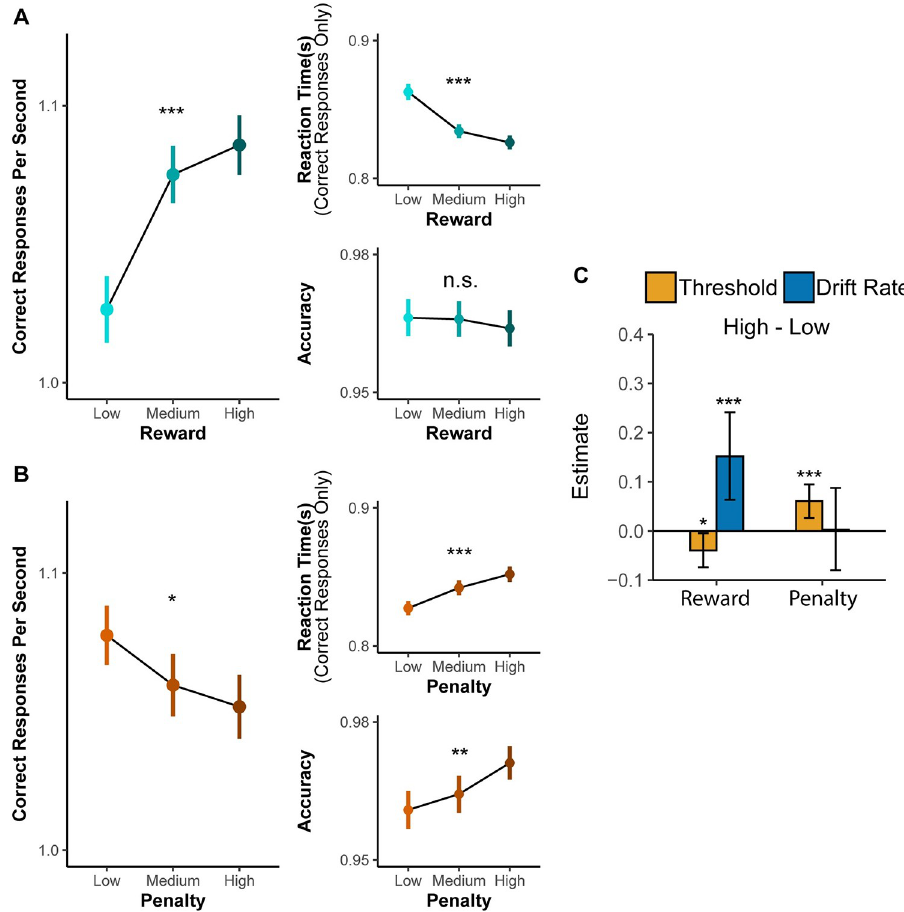
Fig 6. Effects of reward and punishment on overall task performance (A, B) and parameters of drift diffusion model (C) in Study 2. (A) With increasing expected reward, participants completed more correct responses per second within a given interval (Left), which reflect faster responding on correct trials (top right) without any change in overall accuracy (bottom right). (B) With increasing expected punishment, participants instead completed fewer trials per second over an interval, reflecting slower and more accurate responses. (C) Drift rate increases with higher expected reward while threshold increases with higher expected punishment. Error bars reflect 95% CI. n.s.: p > 0.05; � : p < 0.05; �� : p < 0.01; ��� : p <